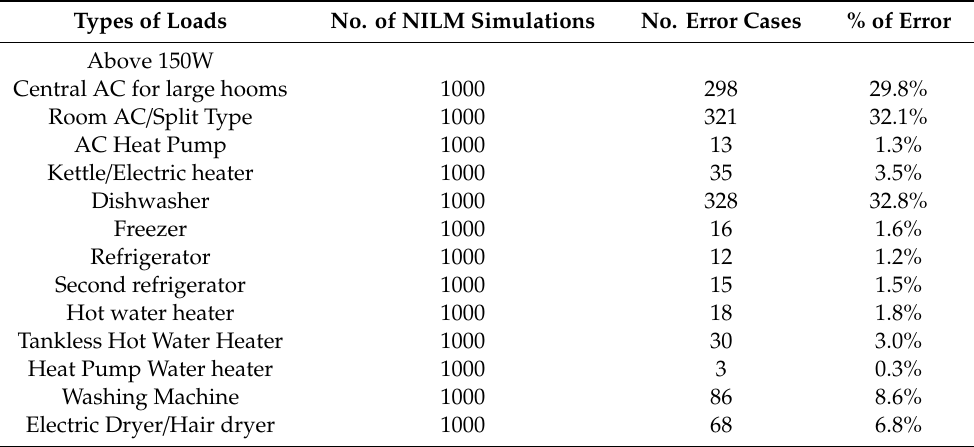
Table 1. Simulations of NILM against known appliances.